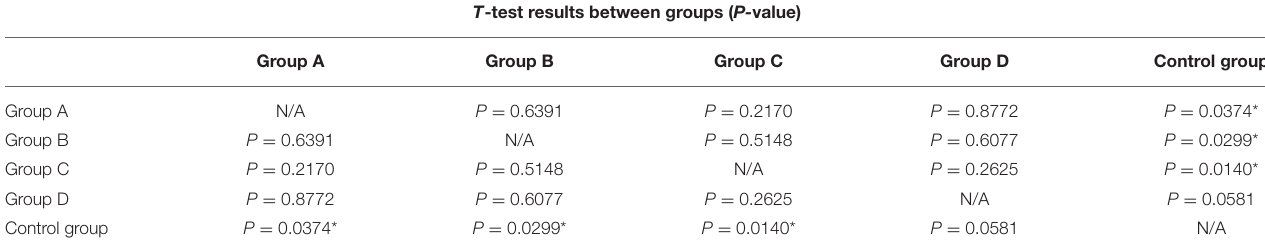
T -test results between groups ( P-